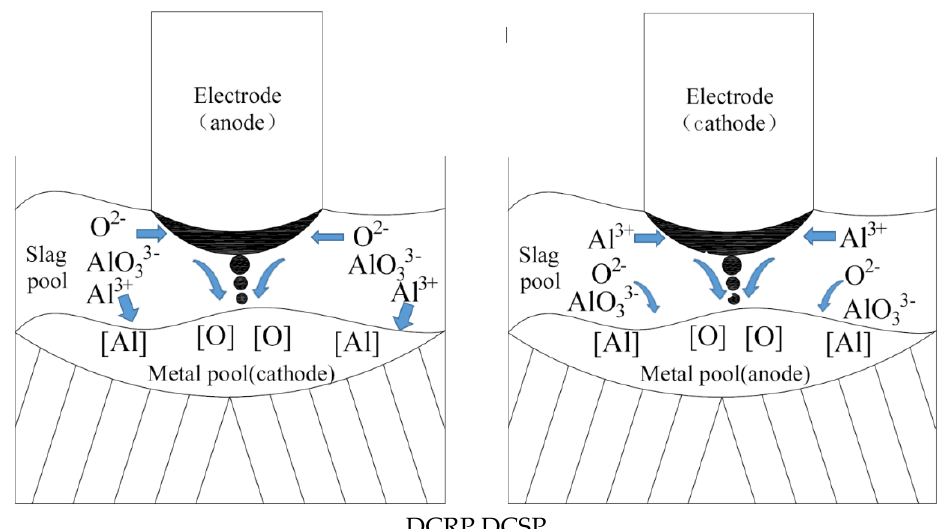
Figure 10. Schematic diagram of Al 2 O 3 electrolysis.